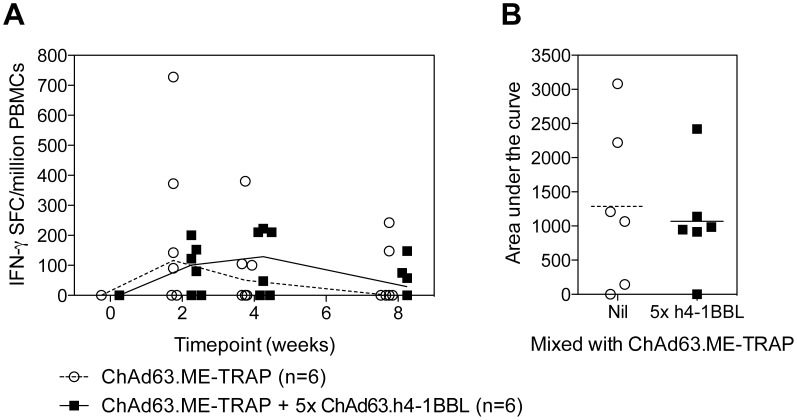
IFN-γ ELISpot responses in rhesus macaques.Male rhesus macaques were immunised i.m. with 108iu ChAd63.ME-TRAP alone or mixed together with 5×108iu ChAd63.h4-1BBL. Blood samples were taken on the day of vaccination and at 2, 4 and 8 weeks post-vaccination and the response to TRAP measured by IFN-γ ELISpot. Graphs represent the total TRAP response at each timepoint (A) or the area under the curve of the TRAP response (B). For each graph the line or bar represents the median response with each individual animal displayed as a single point.